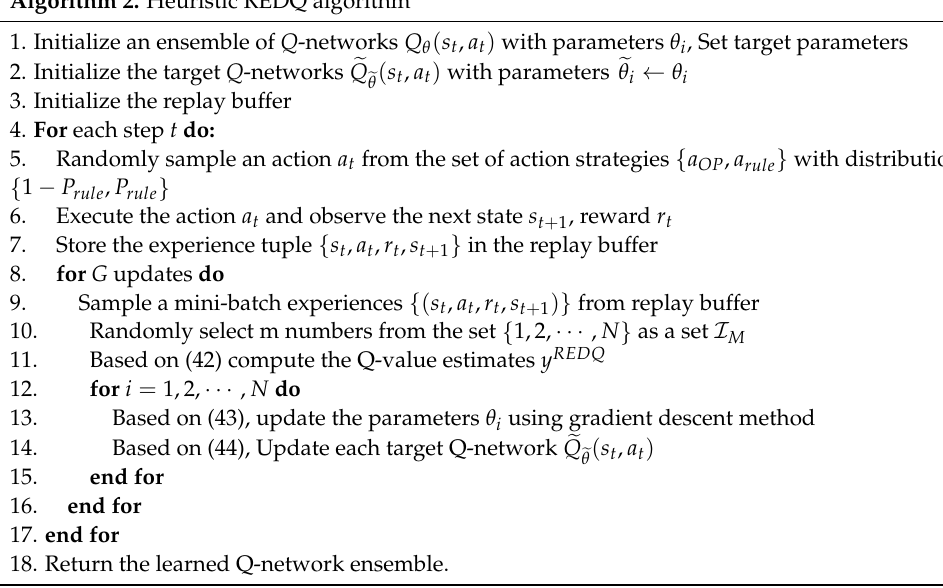
Algorithm 2. Heuristic REDQ